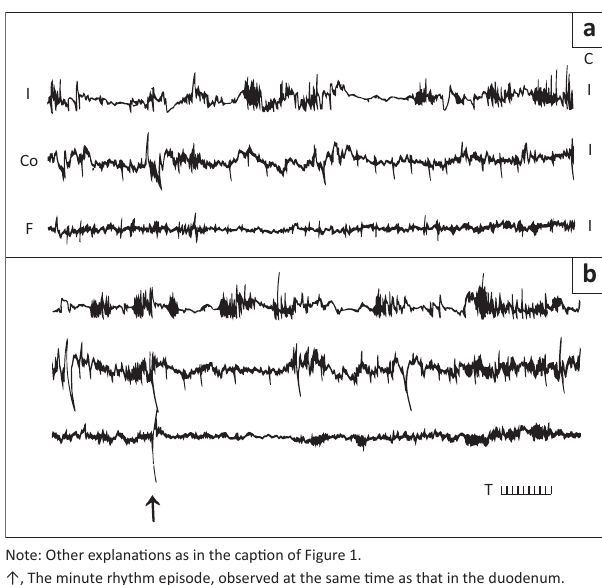
FIGURE 1: Three fragments of the gallbladder myoelectrical recording in fasted rams. (a) Recording during phase 1 of the migrating motility complex observed both in the duodenum (3 min after the onset of duodenal phase 1) and the gallbladder; (b) recording during phase 2a of the migrating motility complex observed both in the duodenum (14 min after the onset of duodenal phase 1) and the gallbladder; and (c) recording during phase 2b of the migrating motility complex observed both in the duodenum (25 after the onset of duodenal phase 1) and the gallbladder.